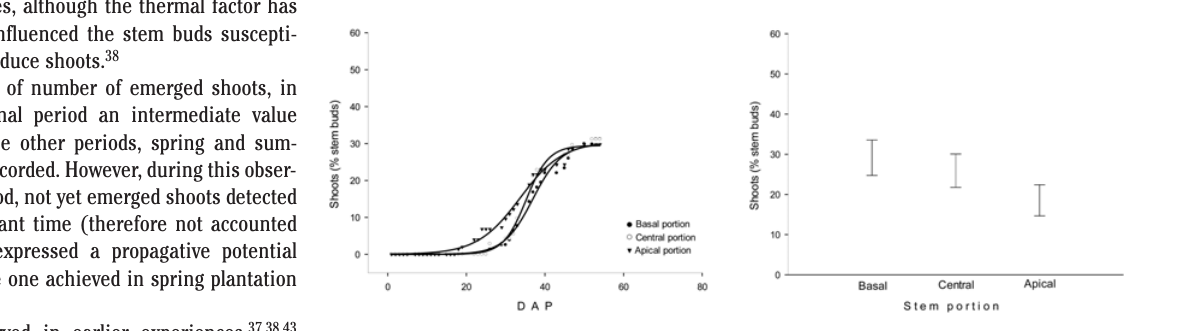
Figure 4. Shoot emergence from different stem portions of old stems in autumn peri- od.